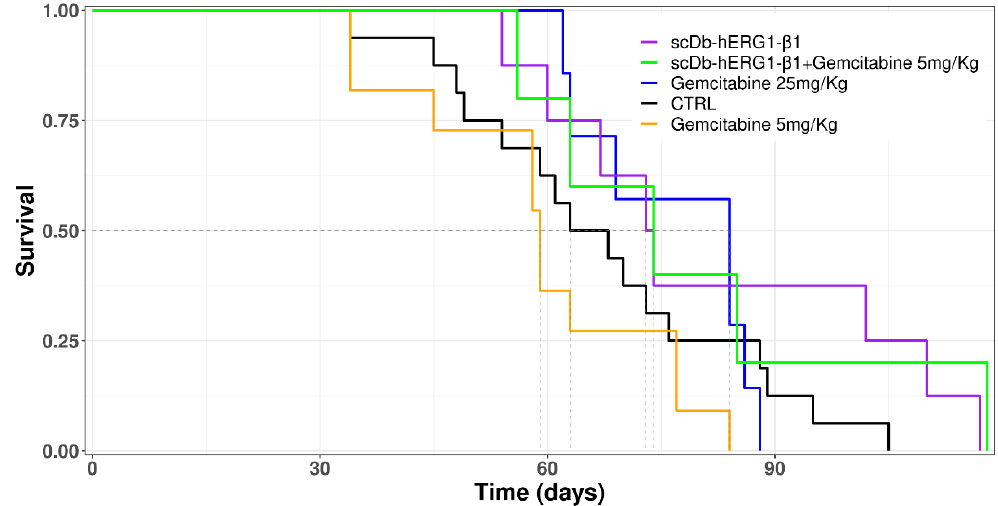
Figure 8. Kaplan–Meier survival curves for all groups with di ff erent treatments.